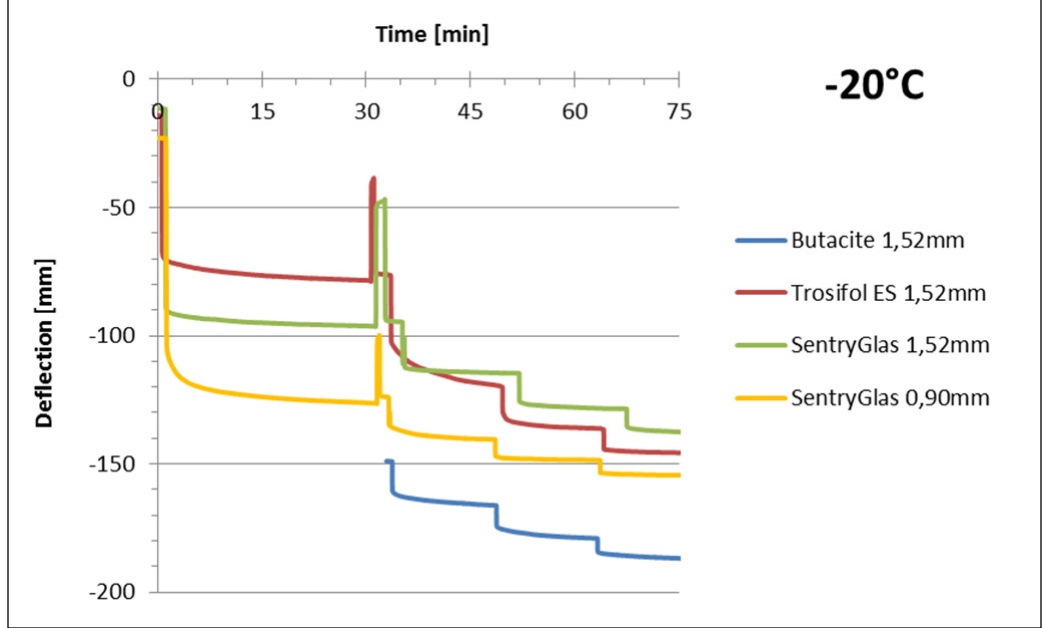
Fig. 14 Deflection Vs Time Measurements @ -20°C Butacite® = Standard PVB, Trosifol® ES = Stiff PVB, SentryGlas® =